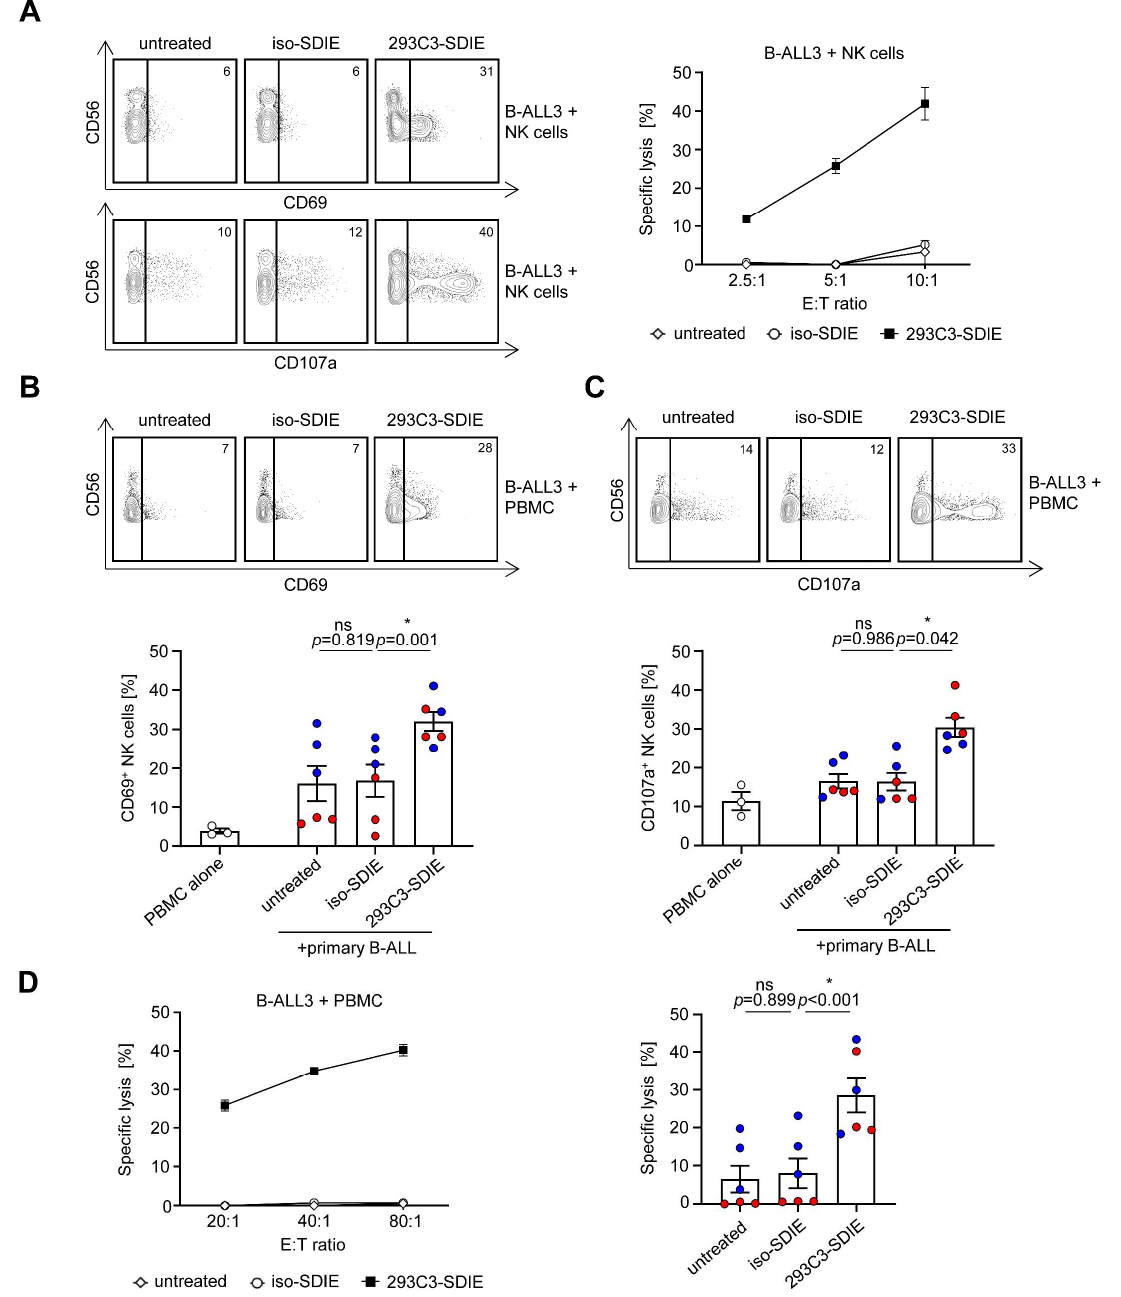
Figure 3. Induction of NK cell reactivity against CD133 + primary B-ALL cells. ( A – D ) Cells of CD133 + B-ALL patients were co-cultured with purified NK cells or PBMCs of healthy donors (E:T ratio of 2.5:1 or indicated E:T ratio) in the presence or absence of 293C3-SDIE and iso-SDIE (both 1 µ g/mL) for 24 h (activation), 4 h (degranulation), or 2 h (Europium assay). To determine the NK cell activation and degranulation, the NK cells were identified as CD56 + CD3 − lymphocytes and stained with CD69 or CD107a with subsequent flow cytometric analysis. Target cell lysis of different B-ALL cell lines was analyzed by Europium assays. ( A ) Exemplary data of purified NK cells tested against primary B-ALL cells (B-ALL3). ( B , C ) Exemplary data from one PBMC donor (upper panel) and pooled results of three PBMC donors tested with two B-ALL patients (B-ALL3: red; B-ALL4: blue) (lower panel) are shown (mean ± SEM). ( D ) Exemplary data from one PBMC donor (left panel) and pooled results of three PBMC donors tested with two B-ALL patients (B-ALL3: red; B-ALL4: blue) at an E:T ratio of 80:1 (right panel) are shown (mean ± SEM). ns, not significant; * significant ( p <